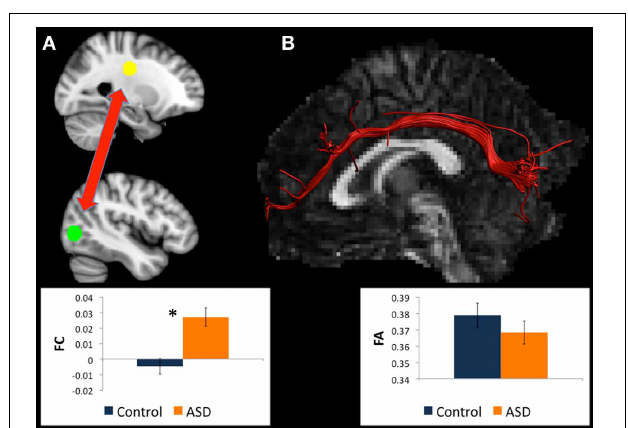
FIGURE 2 | (A) Regions for tractography in left BA19 (green sphere) and left thalamus (yellow sphere). The ASD group showed much weaker functional connectivity relative to controls between these regions during a mental rotation task. The bar graph shows the strength of functional connectivity (FC) in the Control group (blue) and ASD group (orange) between these regions. (B) Example of white matter tracts that directly connect the left BA19 and left thalamus regions in one participant. The bar graph shows Fractional Anisotropy (FA) in the Control group (blue) and ASD group (orange) in these white matter tracts. ∗ indicates statistical significance with p < 0 . 05.